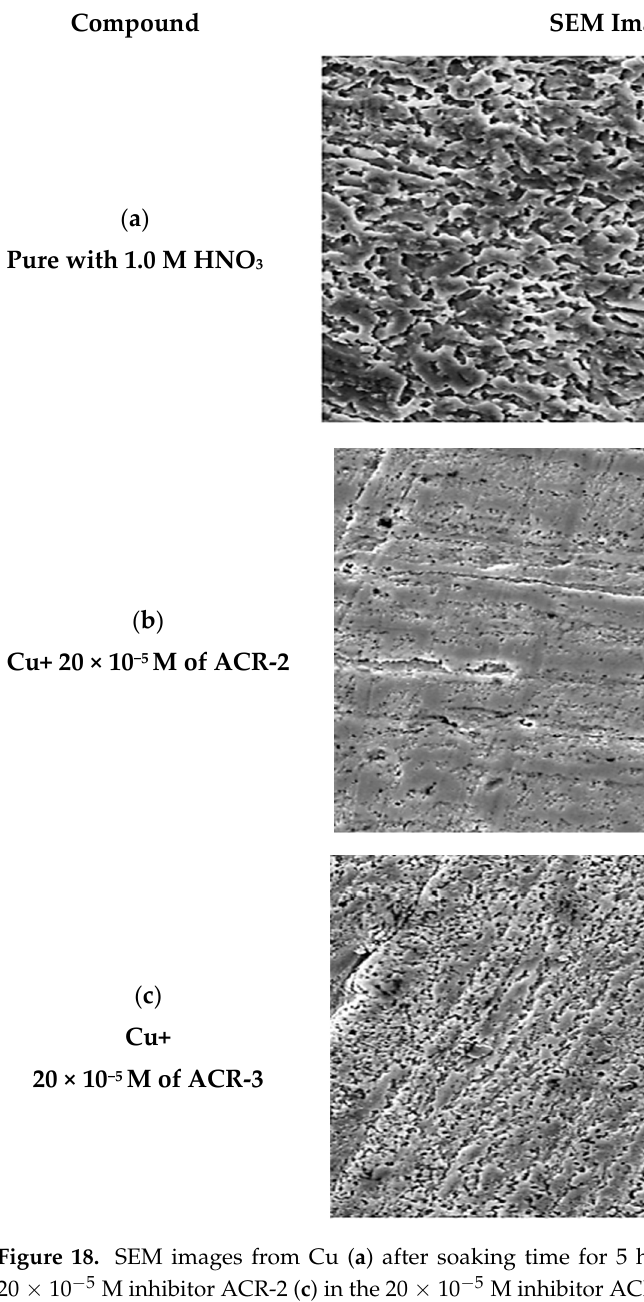
M inhibitor ACR-2 ( c ) in the 20 × 10 − 5 M inhibitor